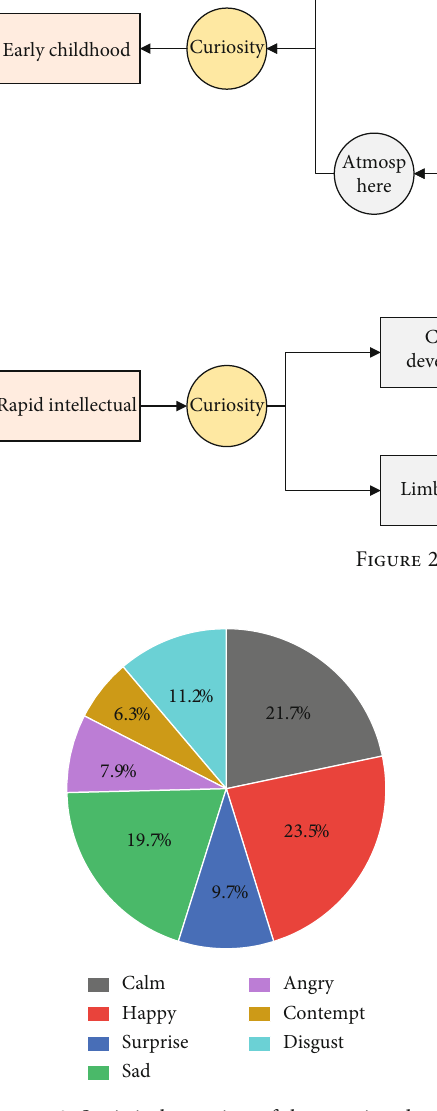
Figure 3: Statistical overview of the emotion